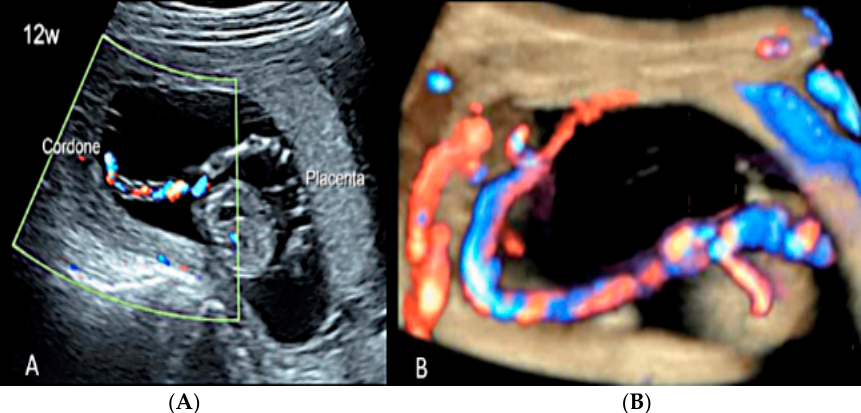
Figure 18. ( A , B ) First trimester (12 weeks) scan showing in two-dimensional- and three-dimensional color Doppler ultrasound a velamentous cord insertion (Cordone: umbilical cord).